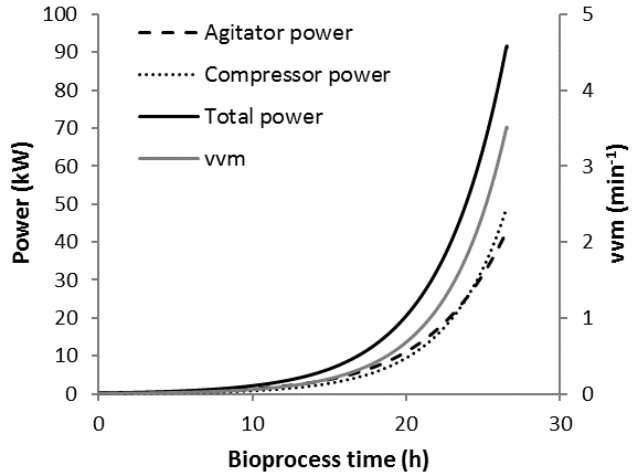
Figure 9. Scenario Cmin: Evolution of vvm and compressor, agitator and total electrical power inputs ( C OL = 2 mg·L −1 ). Table 2. Values of constants in k L a correlations.